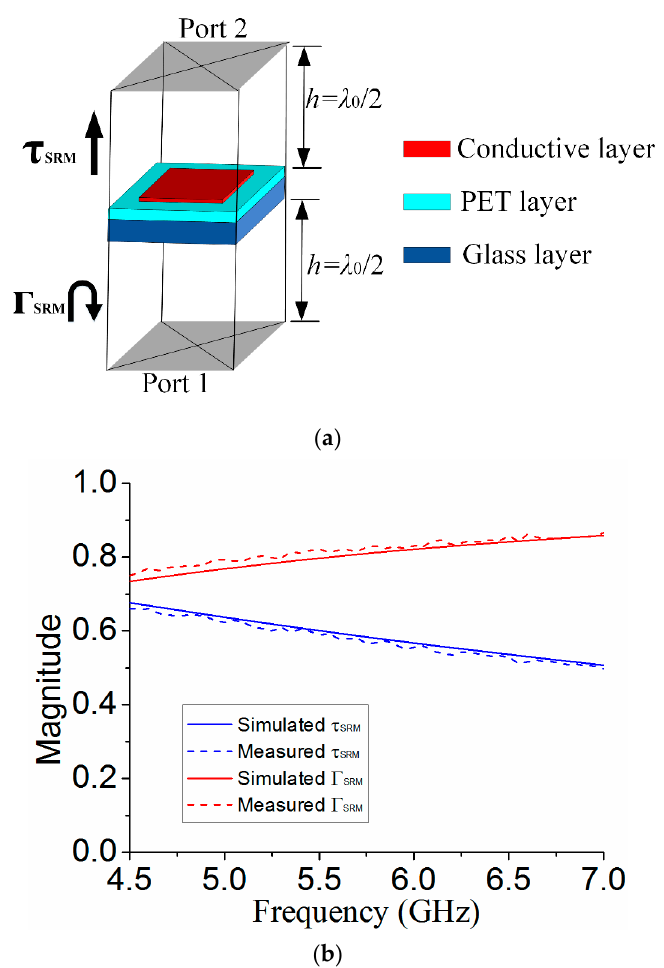
Figure 5. ( a ) Unit cell of the MS using SRM ( b ) simulated and measured reflection and transmission magnitude.